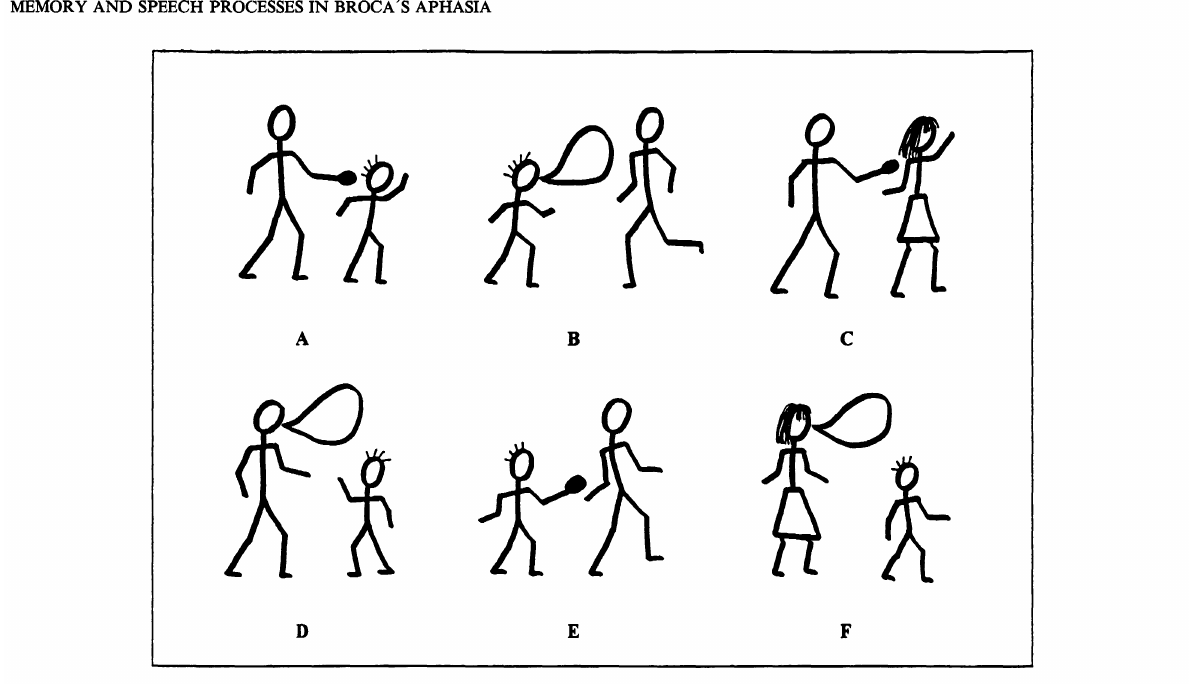
FIG. 1. Example from the sentence comprehension test. The subject has to point to the picture corresponding to the sentence read by the